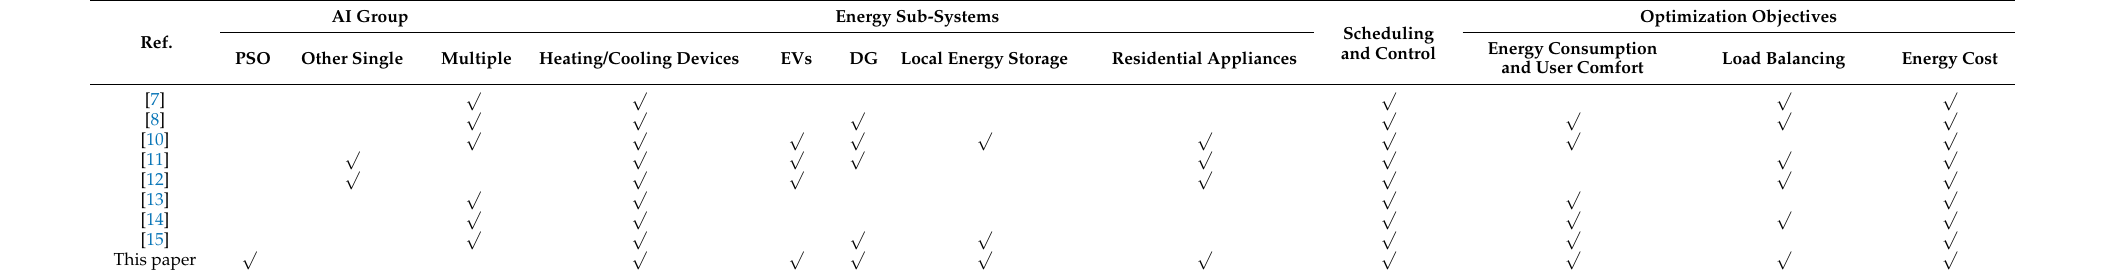
Table 1. Categorization of the relevant review